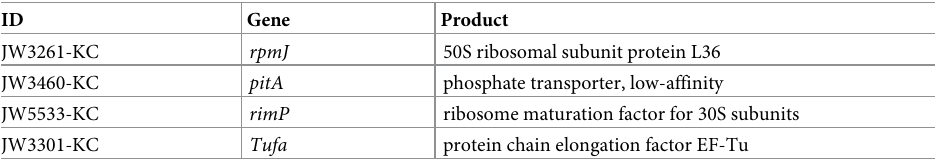
Table 1. E . coli gene knockout mutans resistant to